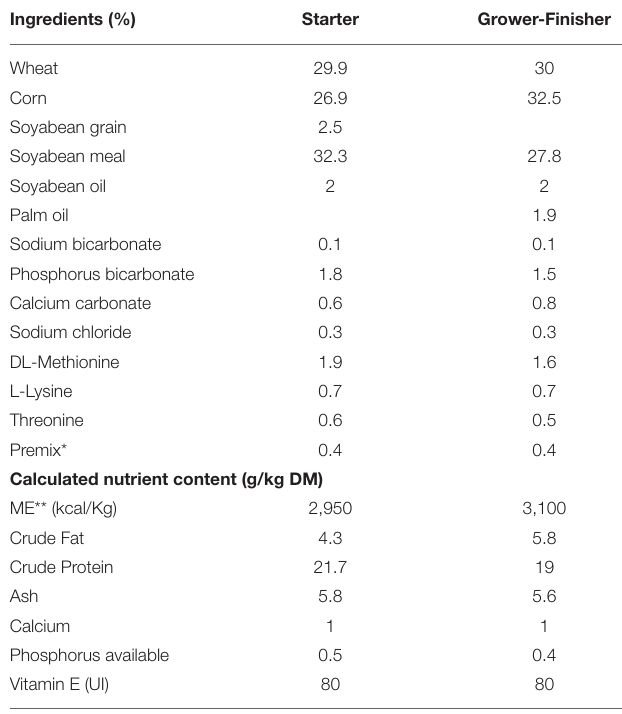
TABLE 1 | Composition of the basal feed of chickens during starter (D1–10) and grower-finisher (D11–35) periods (Design 1). Ingredients